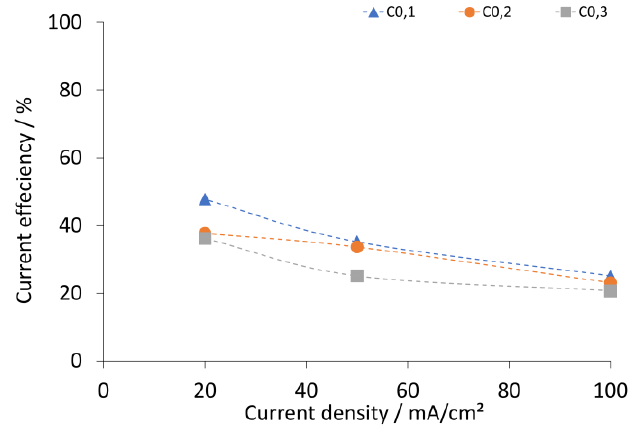
Figure 3. Current efficiency at different current density .